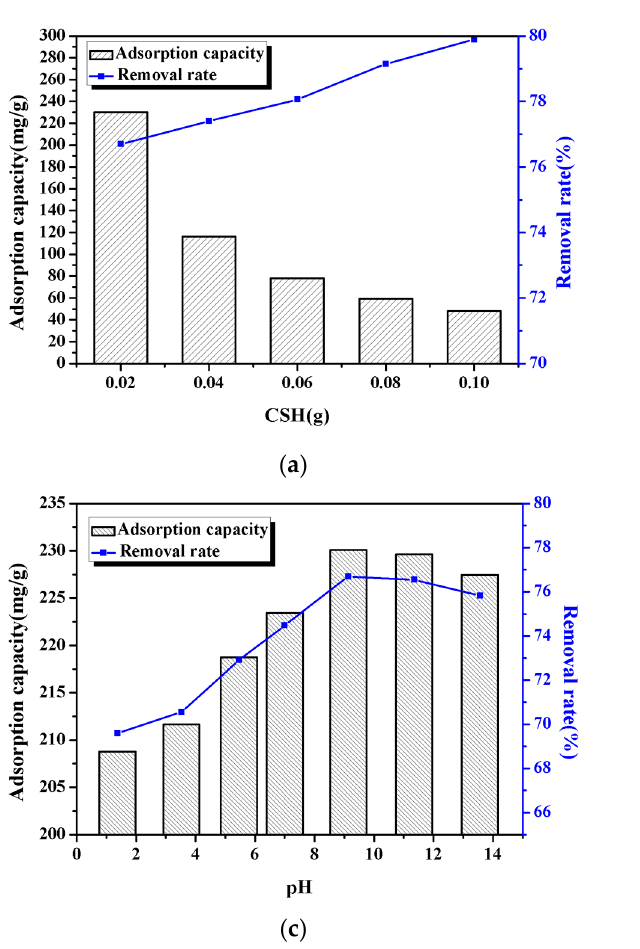
Figure 4. Factors affecting the adsorption of lead ions by CSH: ( a ) CSH dosage, ( b ) adsorption temperature, ( c ) pH value of adsorption solution, ( d ) lead ion concentration .